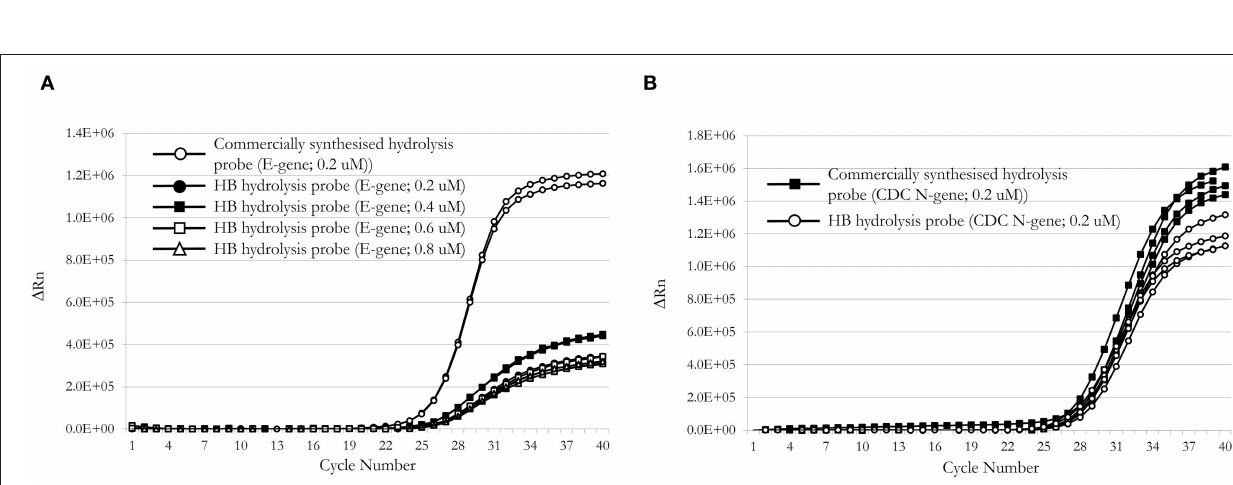
Frontiers in Public Health |